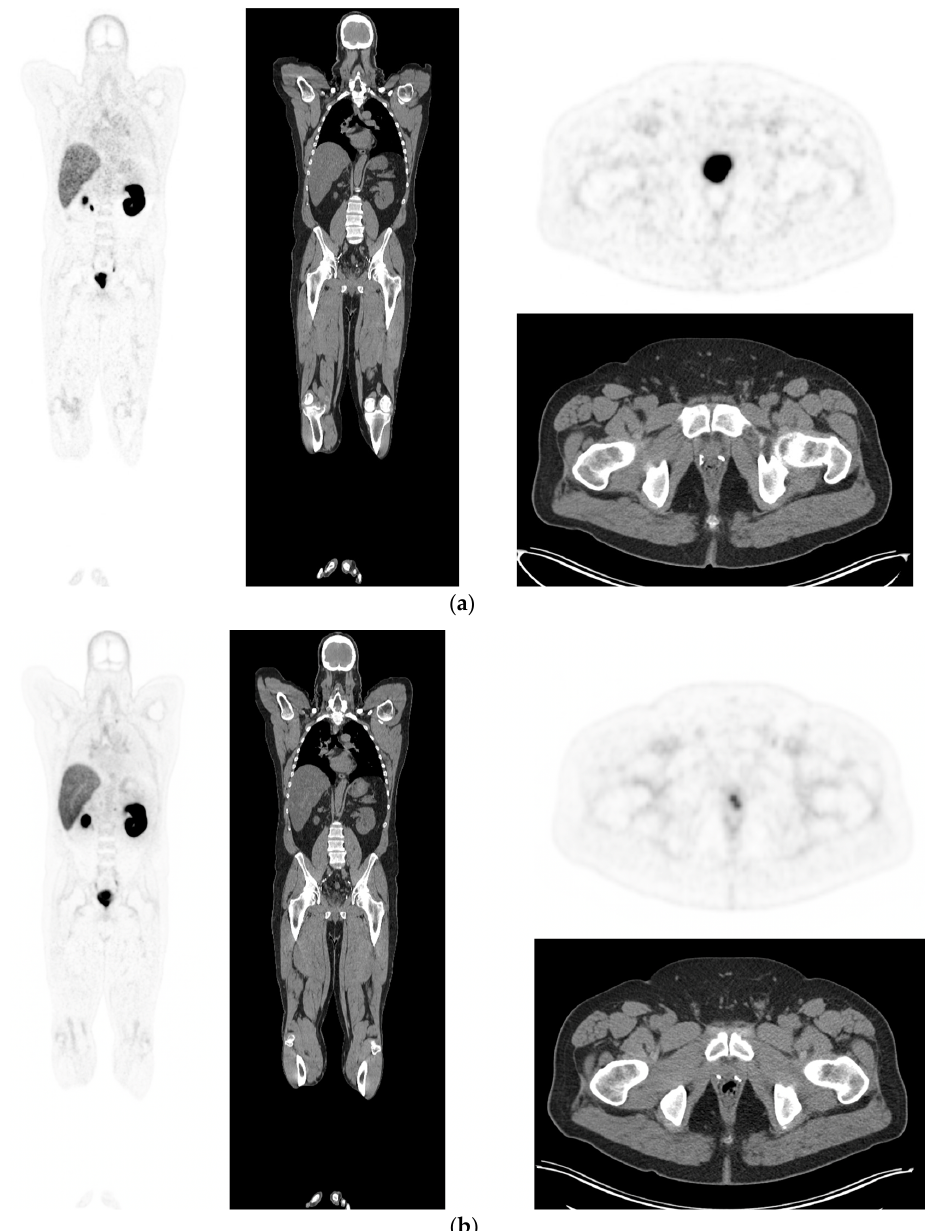
Figure 4. Biochemical recurrence—serial scans. 58 yr old M—radical prostatectomy and node disSection 10 yrs prior; scans done in July 2020 when PSA 0.24 and Sep 2021 when PSA 0.38. ( a ): PSMA PET-CT: July 2020- 68 Ga-PSMA-226 MBq; uptake 49 min; BMI = 35.1; Wt 105 kg; coronal images and transaxial images at level of prostate bed show tracer excretion; rest of study clear. ( b ): PSMA PET-CT: Sep 2021- 68 Ga-PSMA-238 MBq; uptake 50 min; BMI = 35.2; Wt 107 kg; coronal images and transaxial images at level of prostate bed show tracer excretion but with a new small focus of uptake SUV= 6.0 in left side of prostate bed; rest of study